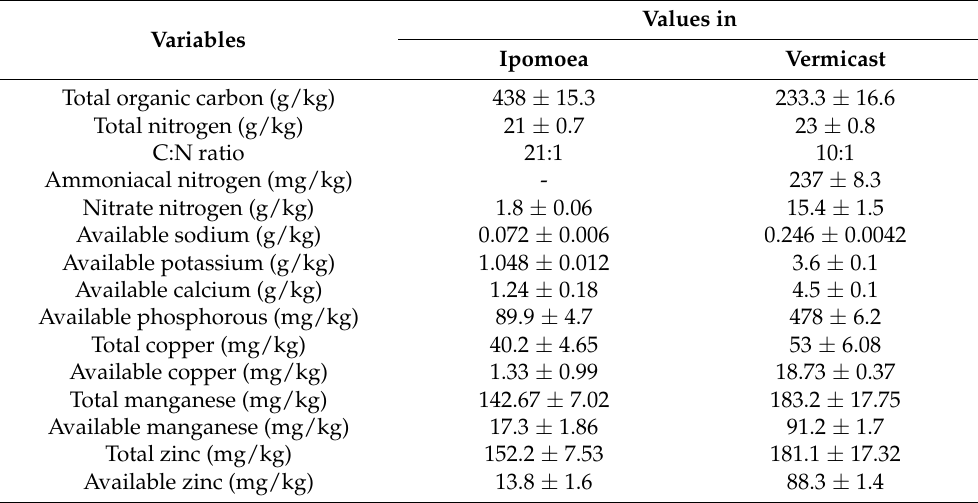
Table 13. Chemical characteristics of ipomoea and its